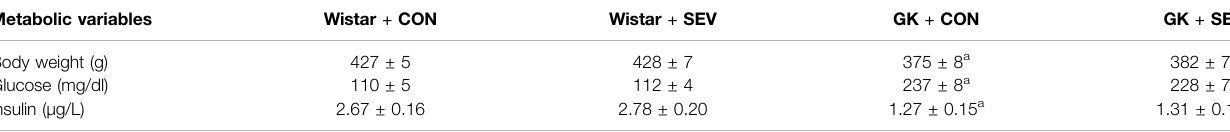
TABLE 1 | Metabolic parameters in Wistar and GK rats. Metabolic variables